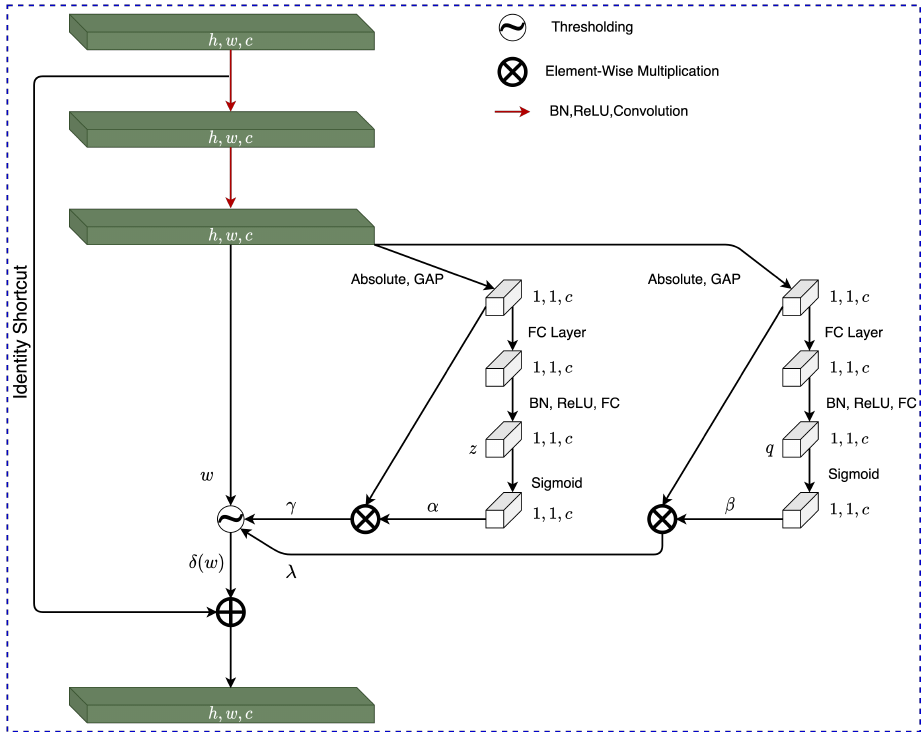
Figure 6. Residual Shrinkage Building Unit-2 Architecture.